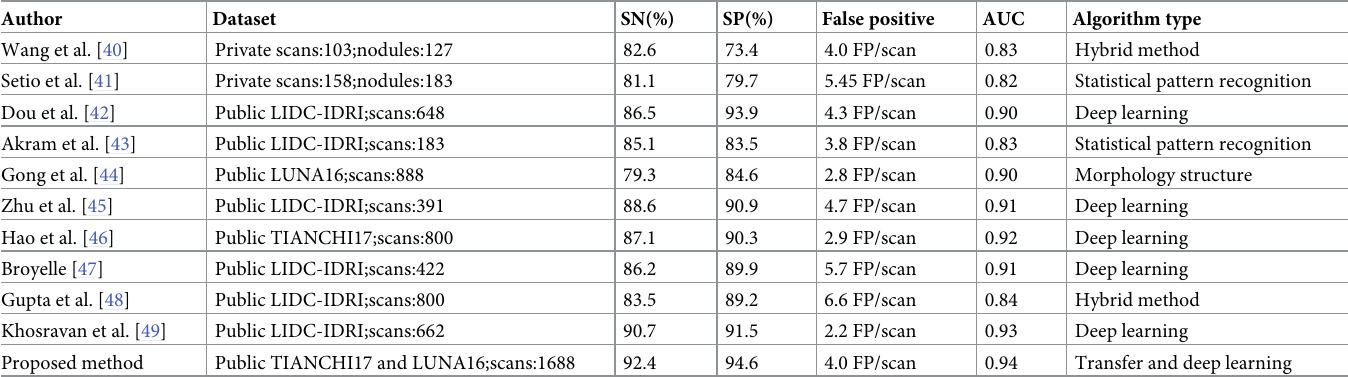
Table 11. Comparison of performance of the proposed pulmonary nodule detection scheme with some existing